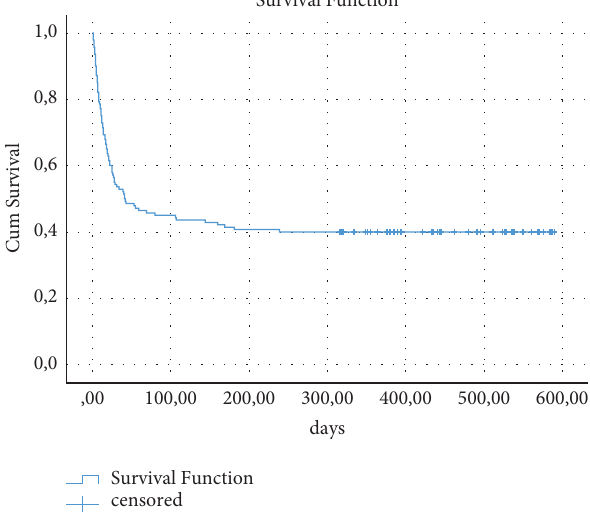
Figure 2: Kaplan–Meier survival analysis by overall